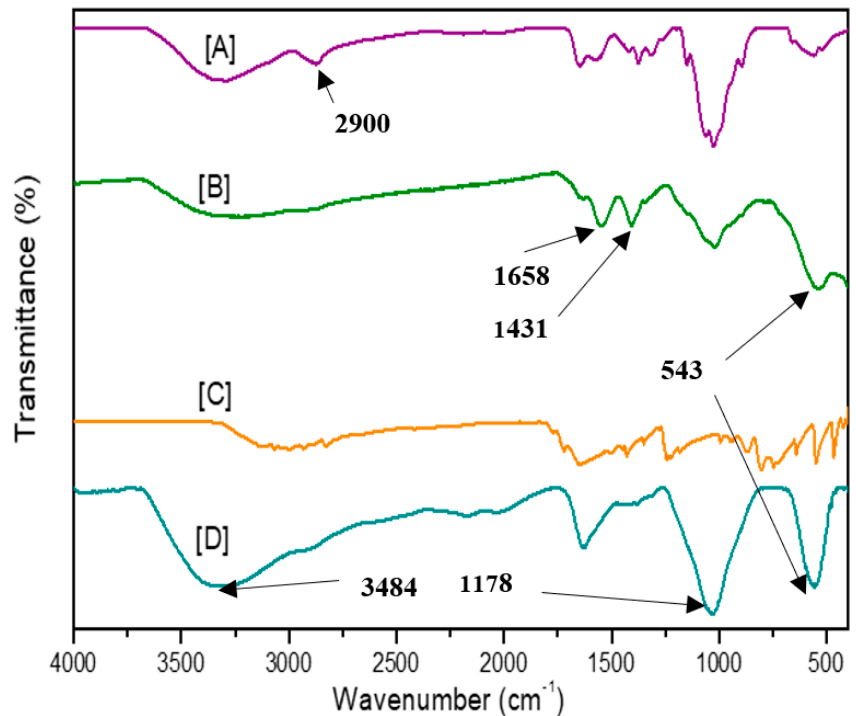
Figure2. FTIRspectraof( A )Chitosan,( B )CS-Mg 0.5 Co 0.5 Fe 2 O 4 ,( C )5-FUand( D )CS-Mg 0.5 Co 0.5 Fe 2 O 4 Figure 2. FTIR spectra of ( A ) Chitosan, ( B ) CS-Mg 0.5 Co 0.5 Fe 2 O 4 , ( C ) 5-FU and ( D ) CS-Mg 0.5 Co 0.5 Fe 2 O 4 -5-FU NPs.